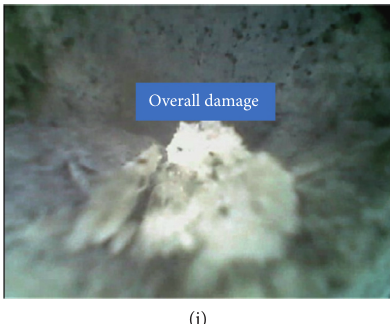
Figure 11: Video capture of the failure process in the marble cave wall, (a) 12 ′ 75.32 ″ ( σ 20 ′ 57.22 ″ ( σ z � 61.06MPa), (d) 27 ′ 28.38 ″ ( σ z � 79.65MPa), (e) 31 ′ 14.52 ″ ( σ z � 90.84MPa), (f) 34 ′ 43.38 ″ ( σ z � 101.53MPa), (g) 39 ′ 26.08 ″ ( σ z � 116.65MPa), (h) 43 ′ 53.32 ″ ( σ z � 129.03MPa), (i) 49 ′ 01.18 ″ ( σ z � 143.33MPa), (j) 52 ′ 73.05 ″ ( σ z �